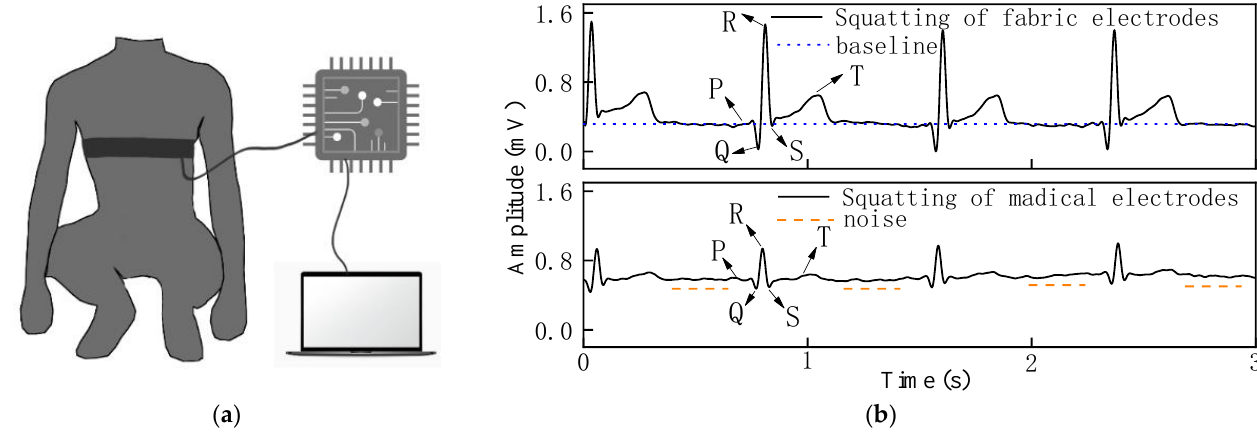
Figure 7. ( a ) Process of measuring ECG signal in squatting state. ( b ) ECG signal of woven fabric electrodes and standard medical electrodes in squatting state.